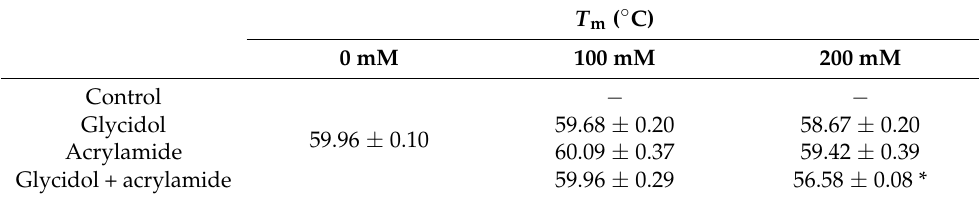
Table 4. Melting temperature of hemoglobin with glycidol and acrylamide. Figure 9. Melting profiles of hemoglobin (Hb) during combined exposure to glycidol and acrylamide. The figure shows the profile of the derivative of fluorescence emission as a function of temperature (dF/dT). Human Hb (0.125 mg/mL) and the ligand (0, 100, and 200 mM each for glycidol and acrylamide) were reacted at 37 °C for 3 h before analysis using the thermal shift assay.